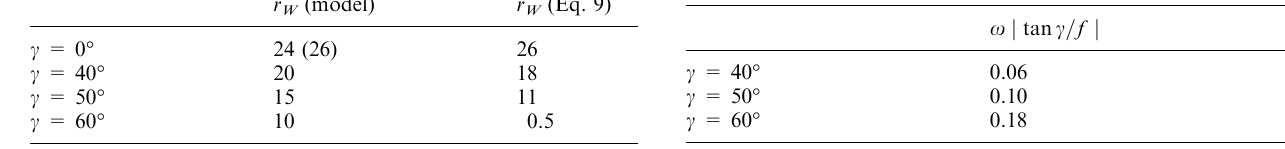
Table 4. Linear westward energy flux coe(cid:129)cients (in % of the incident energy flux). The value in brackets is the coe(cid:129)cient obtained by the inviscid model. T = 60